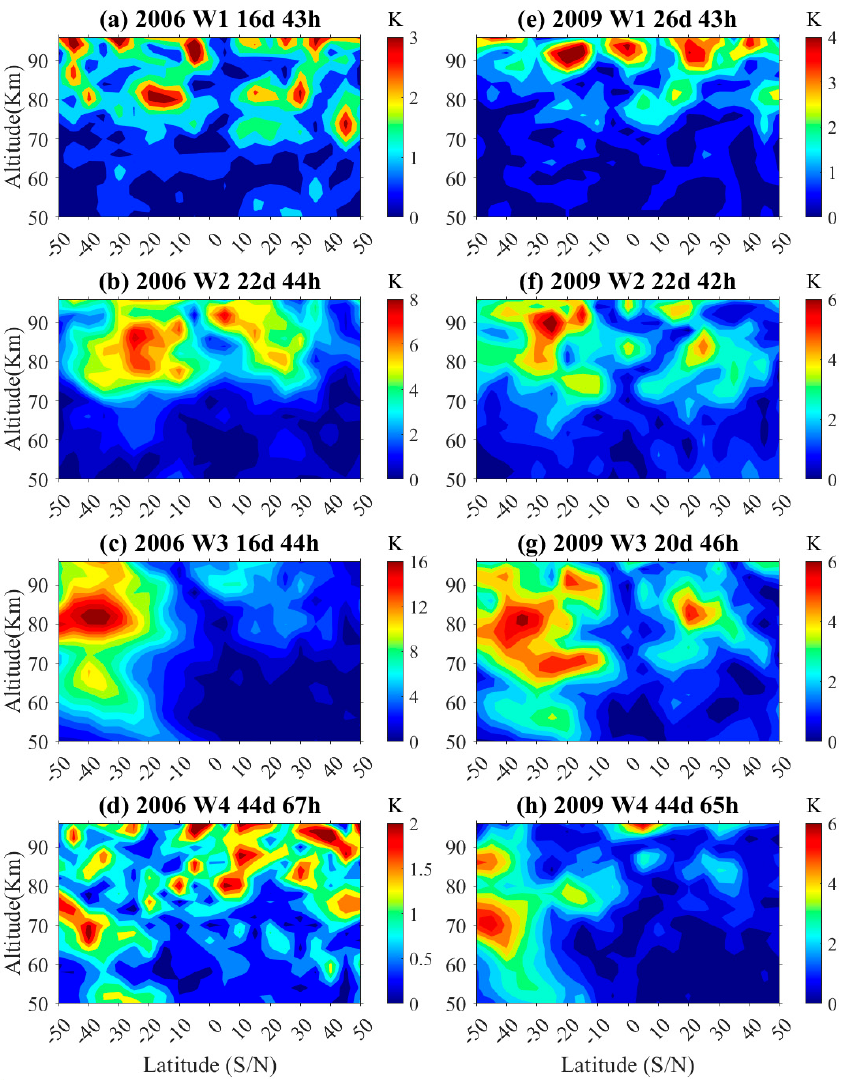
Figure 4. The spatial structures of the W1, W2, W3, and W4 in 2006 ( a – d ) and 2009 ( e – h ). The temporal variations of the stationary planetary wave with wavenumber 1 (SPW1), 2 (SPW2), and 3 (SPW3) at 10 hPa are shown in Figure 5. The vertical black and red lines indicate the starting of the sudden stratospheric warming and the warming peak of